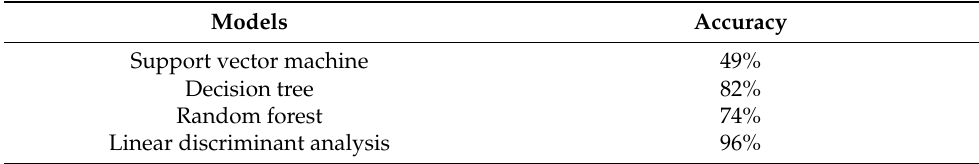
Table 3. Experiment 1.3 results.